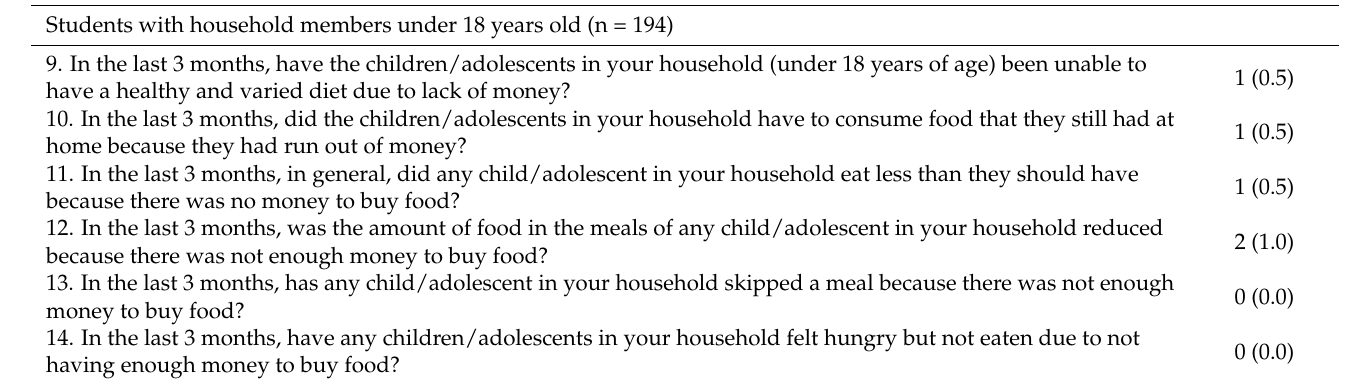
Table 2. Percentage of affirmative answers provided by students for the food insecurity questions.